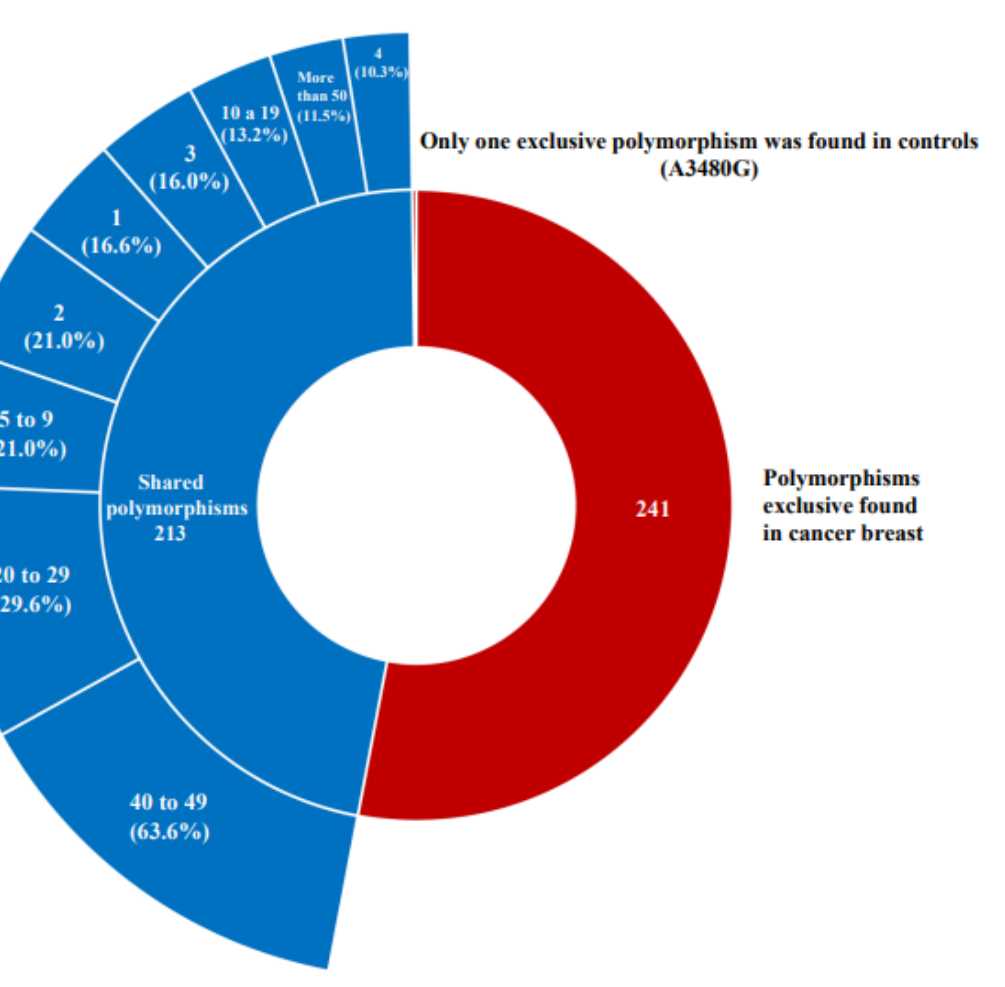
Table 1. Frequent polymorphisms in different mtDNA regions of the breast cancer cases and the controls.